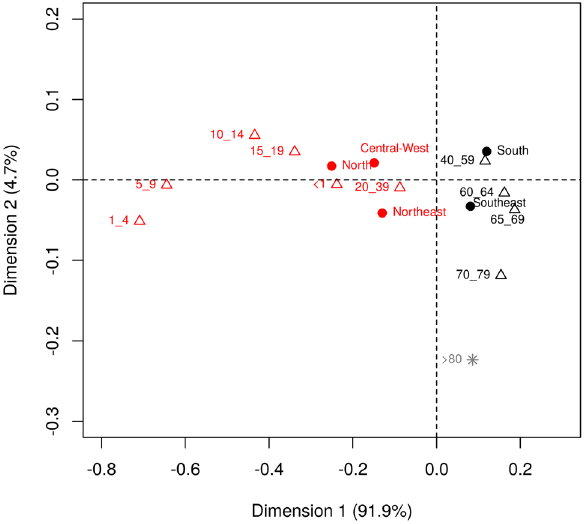
Figure 2. Relationship between age of hepatitis B carriers and regions of Brazil from 2007 to 2018. Age (years) was categorized as < 1; 1–4; 5–9; 10–14; 15–19; 20–39; 40–59; 60–64; 65–69; 70–79; > 80. The five regions of Brazil are represented as North (norte), Northeast (Nord), Midwest (C_O), South (Sul) and Southeast (Sud). This figure was created by using the R software 19 version 3.5.3 (https:// www.R- proje ct. org/).